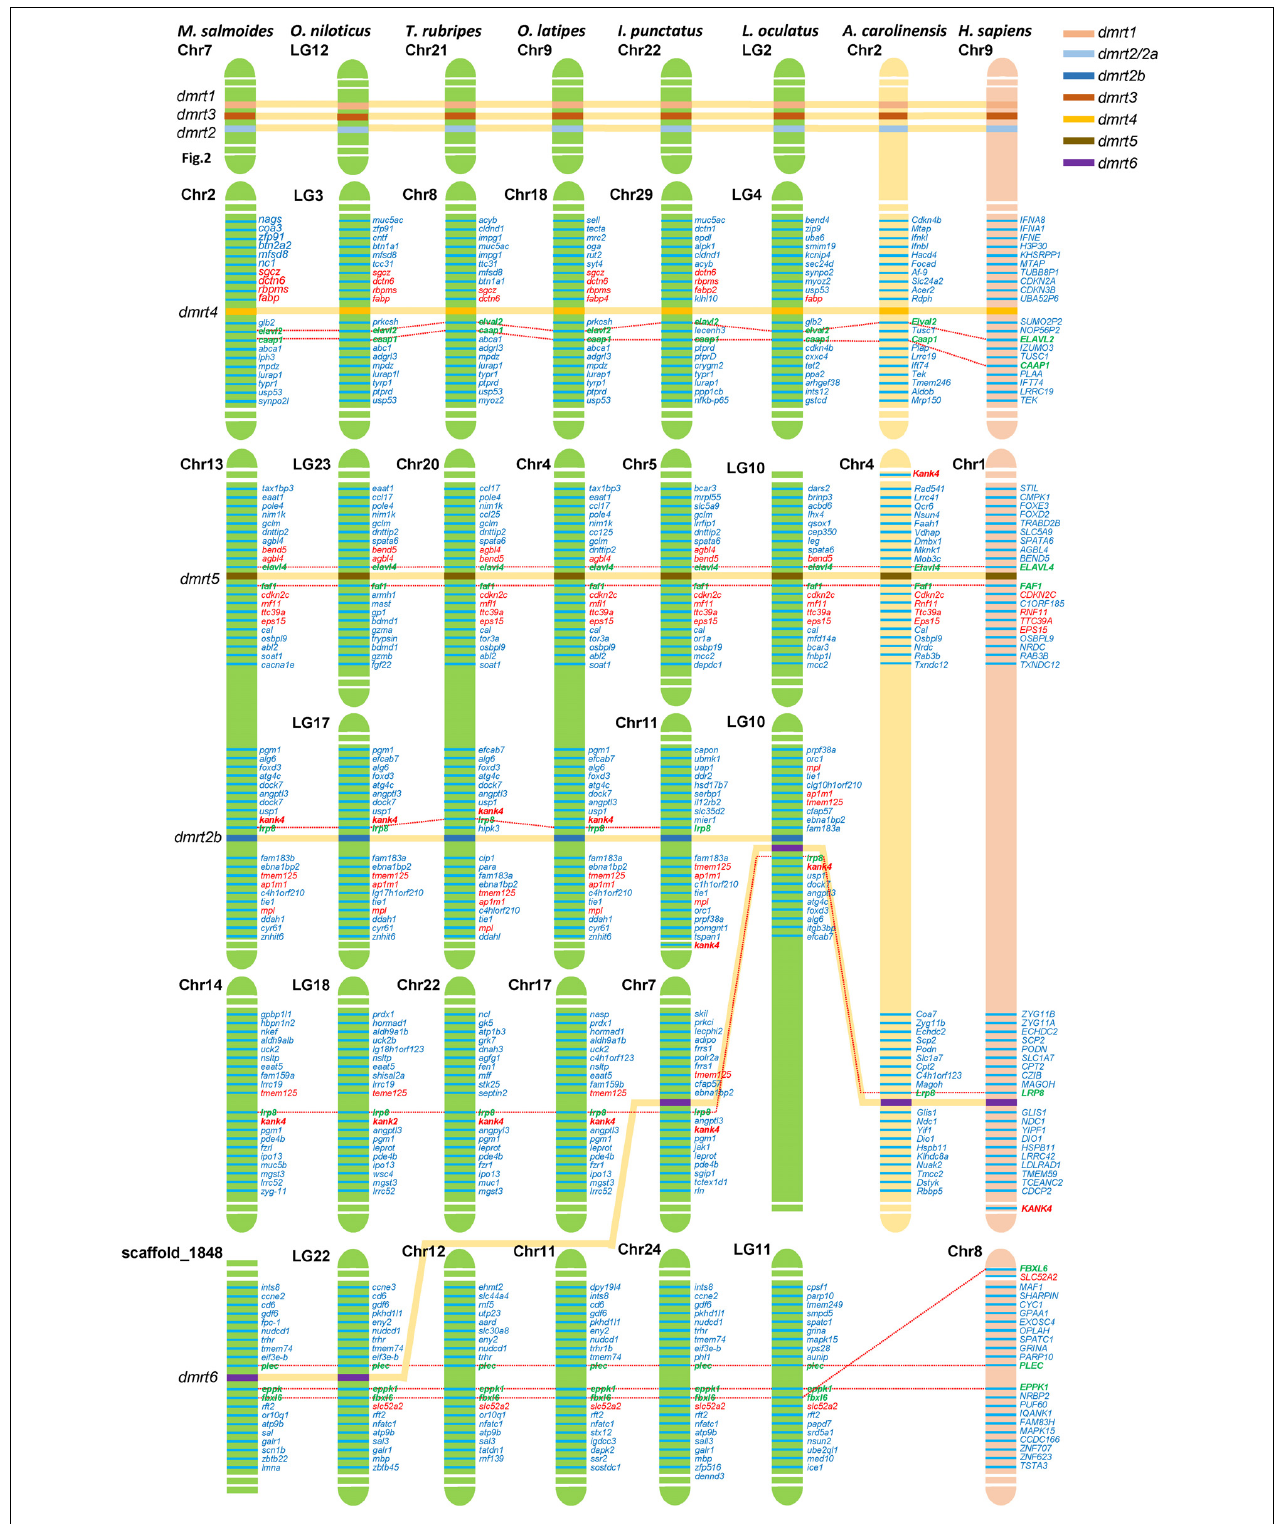
FIGURE 5 | Synteny of dmrt genes in various fish species. The synteny analyses were performed in eight vertebrate species ( M. salmoides , O. niloticus , T. rubripes , O. latipes , I. punctatus , L. oculatus , A. carolinensis , and H. sapiens ). Chr., chromosome; LG, linkage group. The most conserved surrounding genes of dmrt genes were shown in green and bold fonts. The most conserved were shown in red fonts.